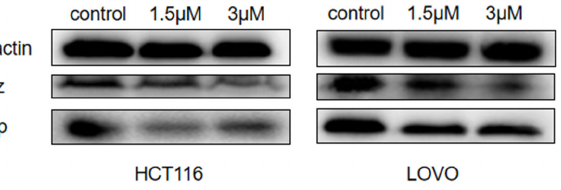
Figure 12. Electrophoresis of Yaz and TAZ protein expression in colon cancer cells after DTB intervention.